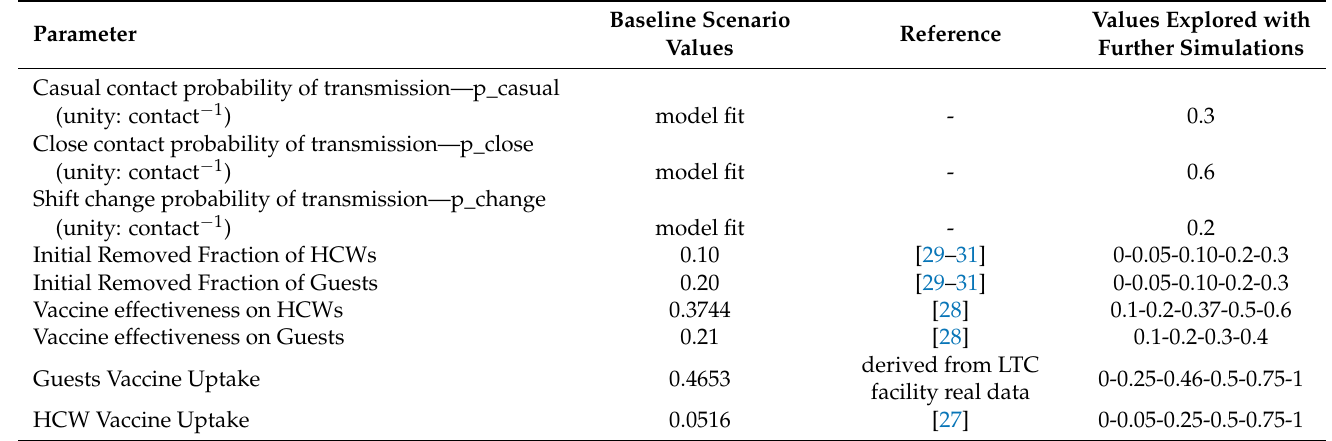
Table 1. Summary of the main parameters of the mathematical